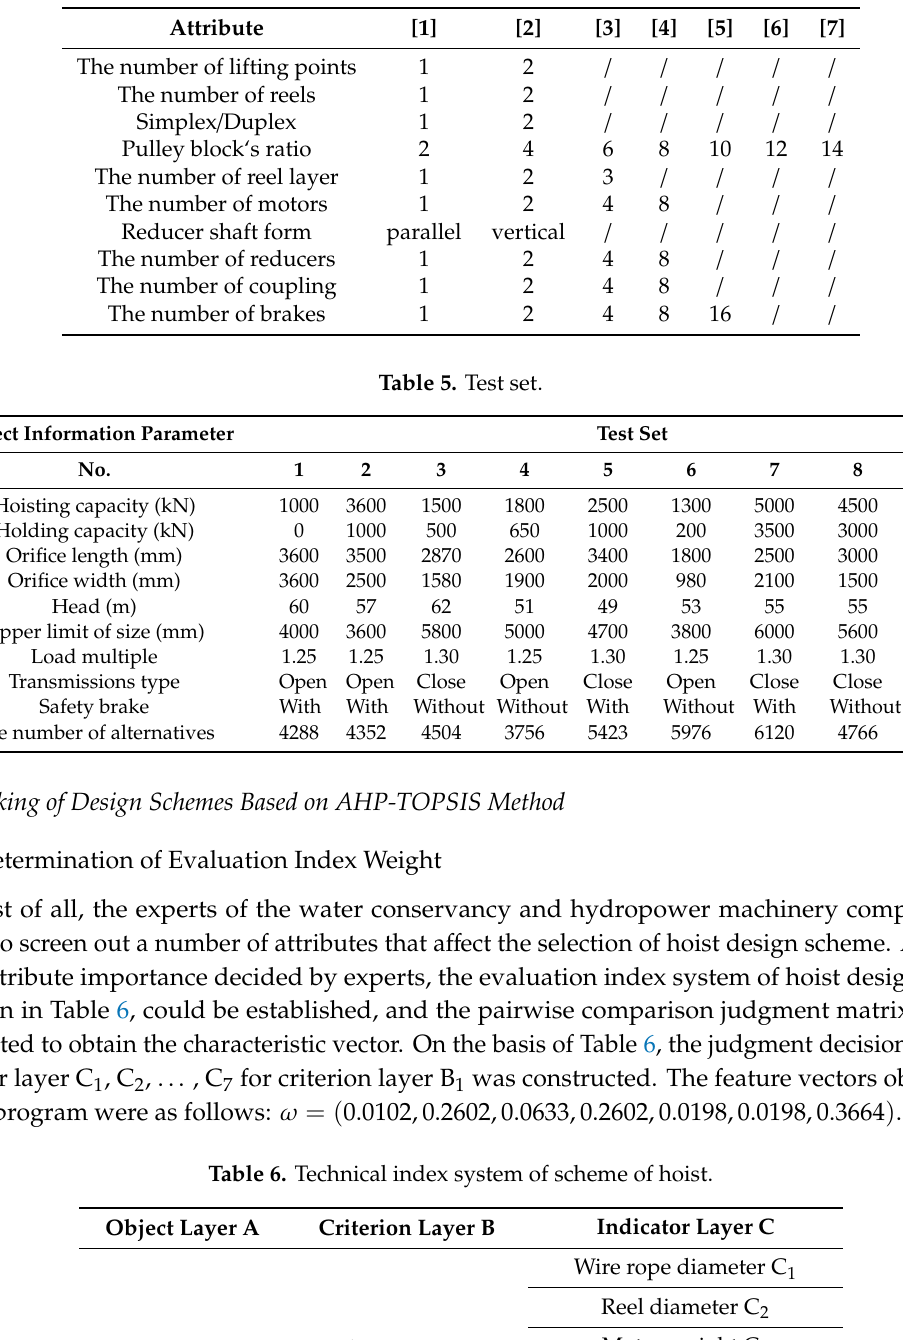
Table 4. Attribute structure of hoist.